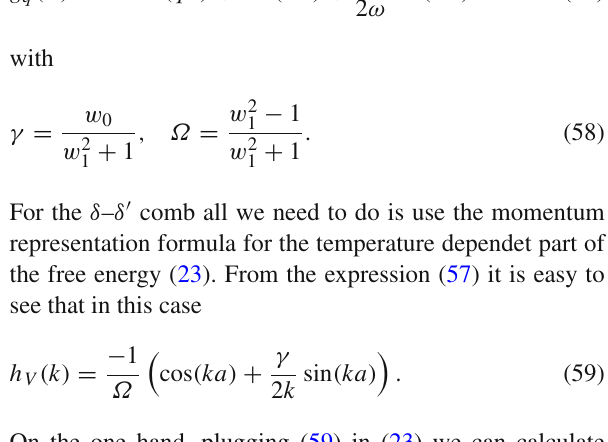
Fig. 6 Free energy (cid:8) T F , (23) for T = 0 . 5 for the potential (56) in the parameter space Ω − γ . We have chosen for the lattice spacing a = 1